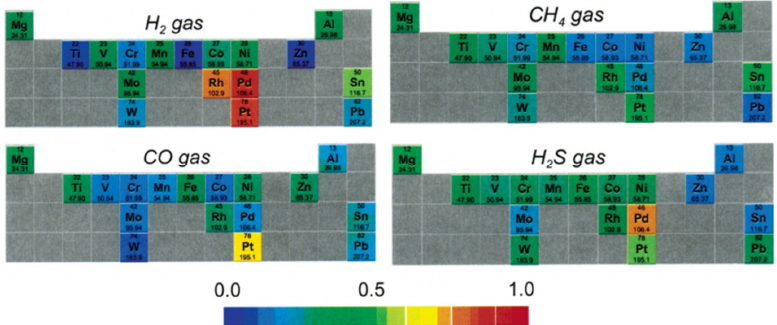
Figure 4. Correlation coefficients relating the conductance of devices decorated via metal evaporation with the gas profile of the tested gases, from 0 (no response) to 1 (maximal response). The catalytic metals were evaporated on carbon nanotube devices and tested for H 2 , CO, CH 4 , and H 2 S gases as highlighted in the Periodic Table. Reproduced with permission from ref. [65].